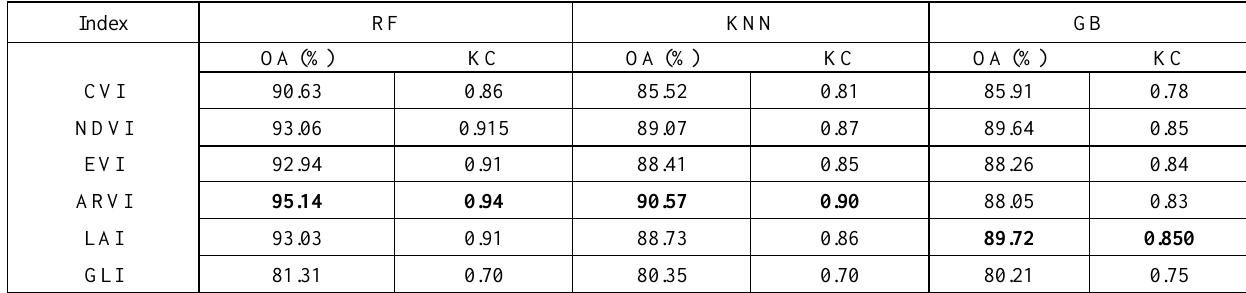
Table 3 . Accuracy assessment of different ML methods for crop mapping with various inputs. The bold values show the highest accuracies (OA: overall accuracy, KC: kappa